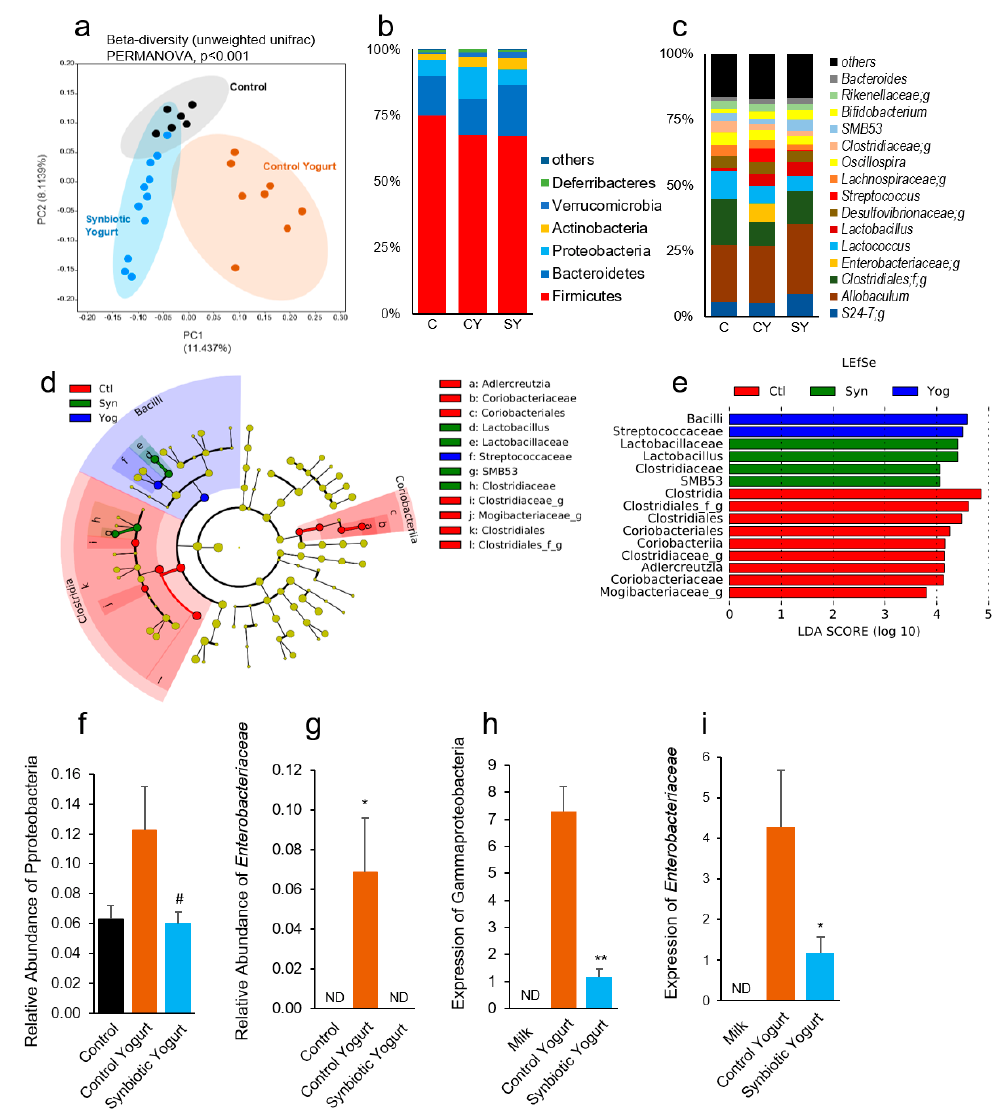
Figure 3. Synbiotic yogurt feeding protects against high-fat diet-induced gut microbiome dysbiosis. ( a ) Principal component analysis showing β -diversity clustering of the gut microbiome of mice fed a high-fat diet supplemented with milk, control yogurt, and our synbiotic yogurt. ( b ) Major bacterial phyla. ( c ) Major bacterial genera. ( d , e ) Cladogram ( d ) and linear discrimination analysis effect size (LefSe) ( e ) showing clustering in the gut microbiome. ( f , g ) Abundances of Proteobacteria ( f ) and Enterobacteriaceae ( g ) in mouse feces. ( h , i ) Expression of Gammaproteobacteria ( h ) and Enterobacteriaceae ( i ) in milk, control yogurt, and our synbiotic yogurt using real-time PCR. Control yogurt was used as the control because these bacteria were not detected in boiled milk. Values are mean ± standard error of the mean (error bars). * p < 0.05; ** p < 0.001; # p < 0.05 compared to control yogurt. ND, Not detected; SY/Syn, Synbiotic yogurt; CY/Yog, Control